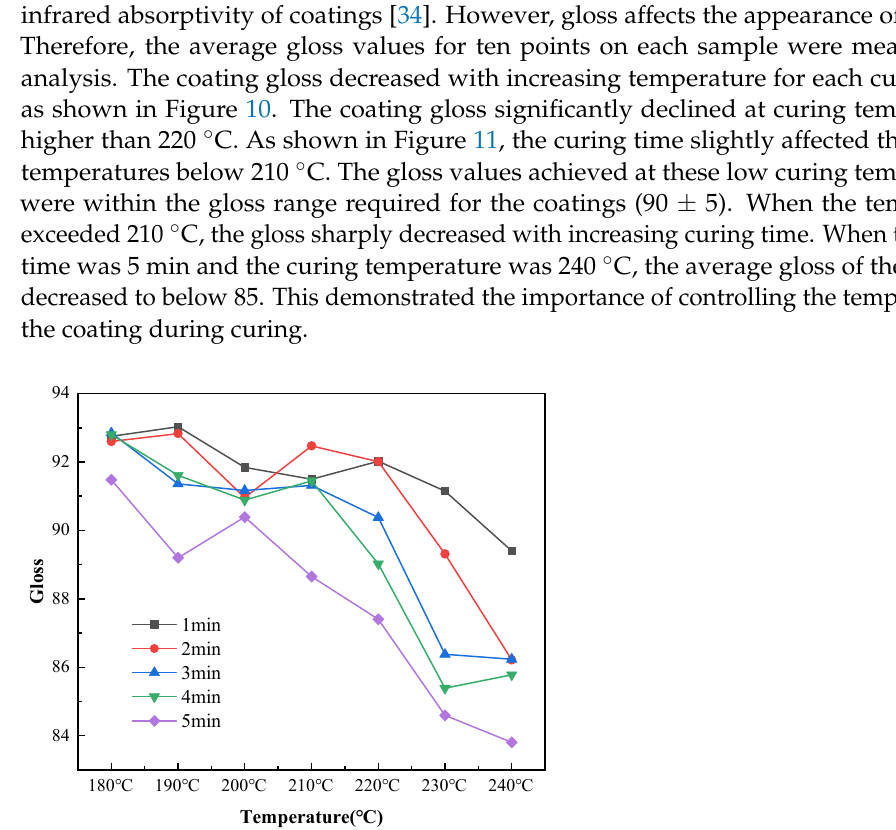
Figure 10. Changes in the coating gloss with curing temperature after different curing times.